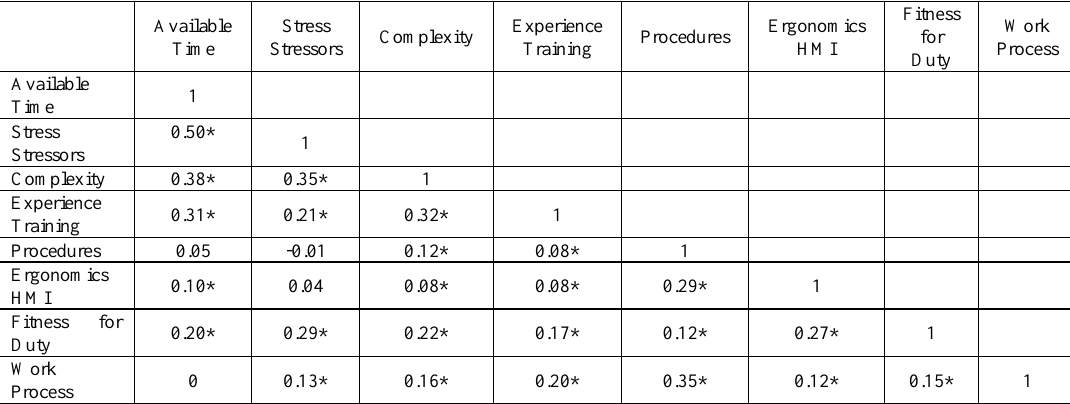
Experience Procedures Training